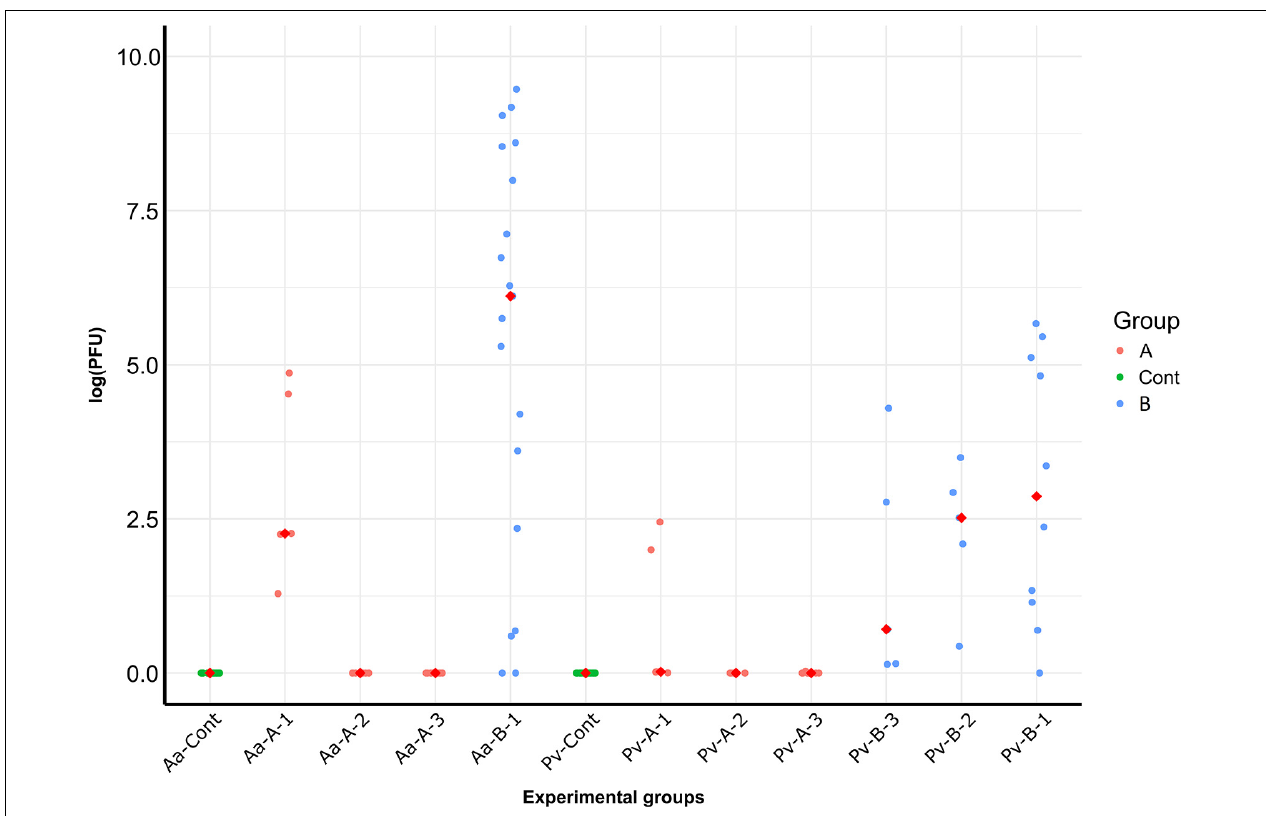
FIGURE 2 | PFU values of A. astaci DNA detected in the crayfish of the different experimental groups, divided per sampling date. Medians are represented as red diamonds. Pv, marbled crayfish; Aa, noble crayfish; A, A. astaci of haplogroup A-challenged; B, A. astaci of haplogroup-B challenged; 1, first sampling point, day 3; 2, second sampling point, day 21; 3, third sampling point, day 45. TABLE 2 | Median of the PCR forming units (PFU) value and the range of the PFU values of each experimental group by sampling points. Species Group Sampling time point Number of samples Positive samples PFUs (median) PFUs